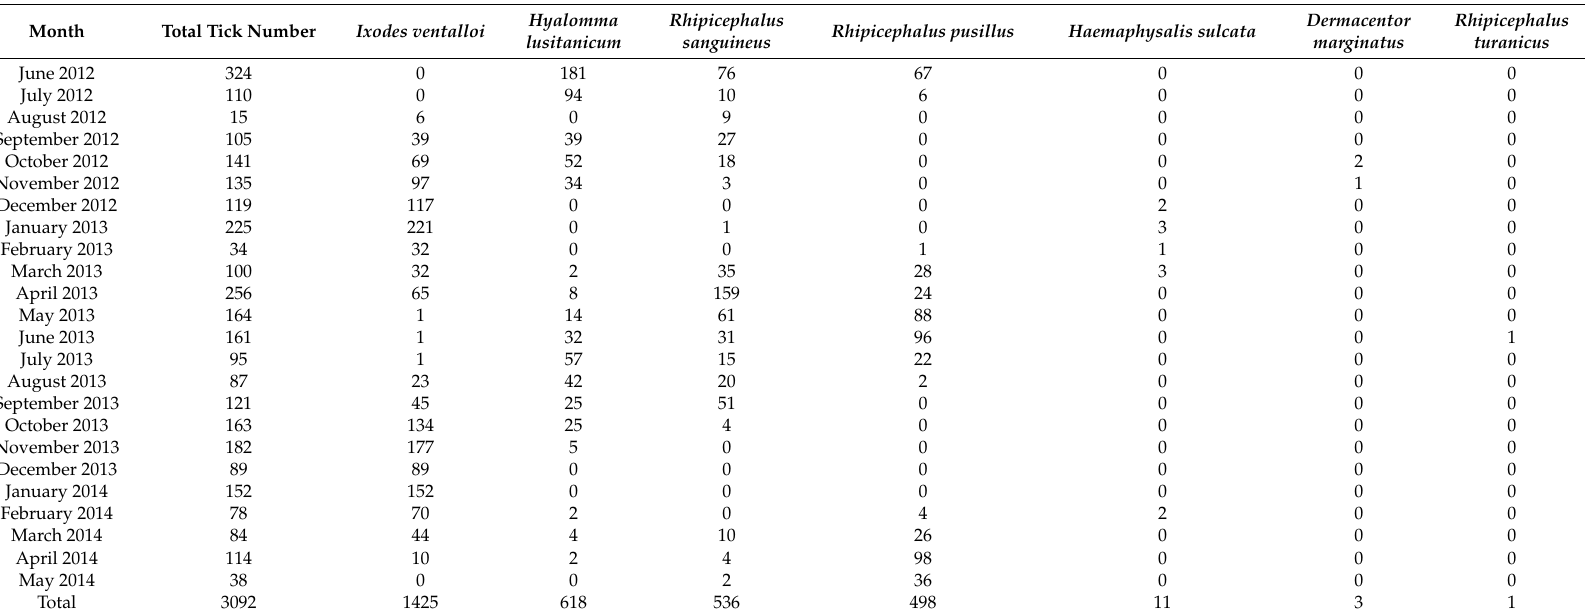
Table 1. Number of collected ticks for each month of monitoring, reported for each tick